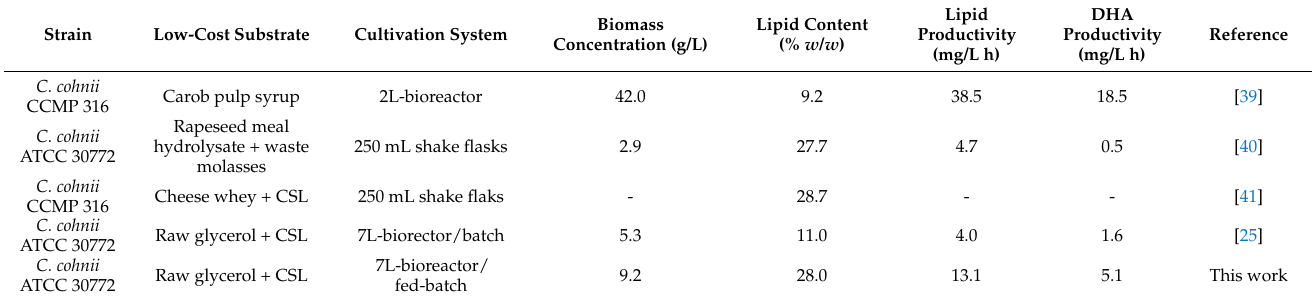
Table 1. Low-cost substrates used to grow C. cohnii for lipid and DHA